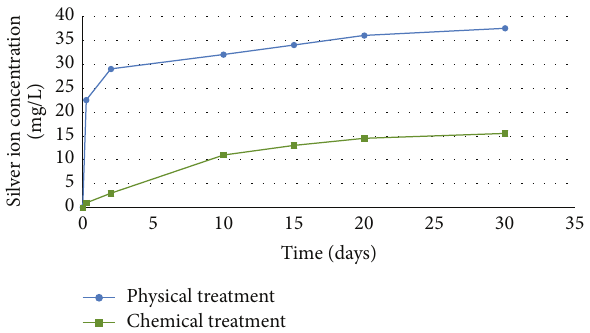
Figure 4: Concentration of silver released to aqueous media versus time plot for